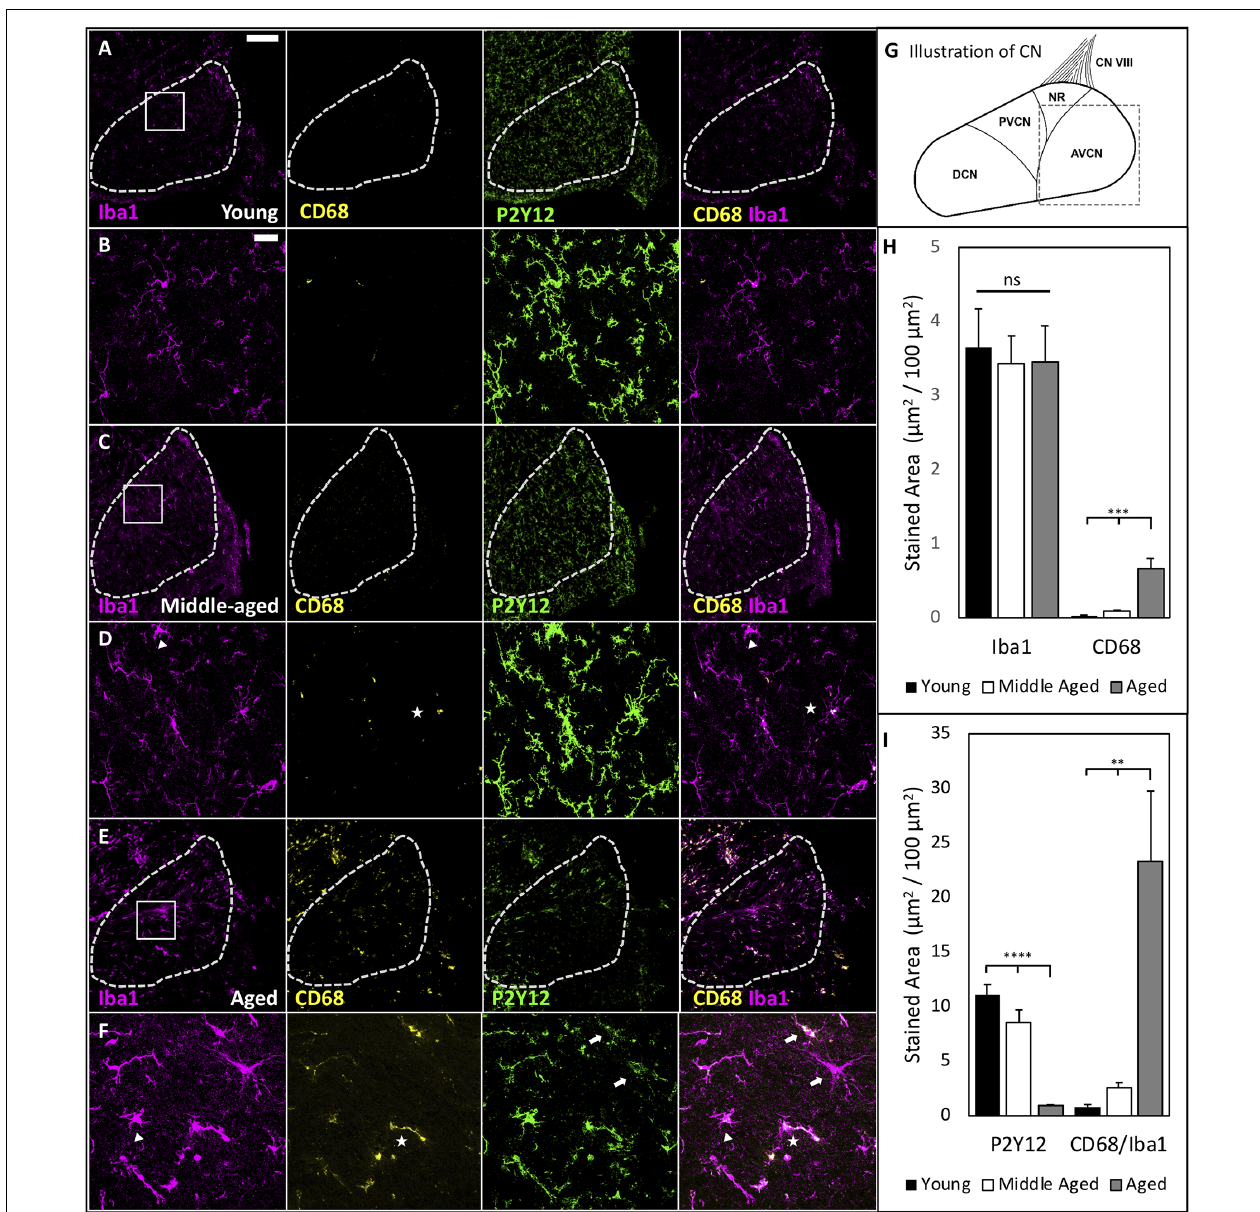
FIGURE 3 | Age-associated microglia activation in the CN. (A) Representative images showing the staining of Iba1, CD68, P2Y12, and the overlapped image of Iba1 and CD68 in the AVCN of young mice. Dashed line marks the AVCN area for analysis; scale bar: 200 µ m. (B) Magnified view of the ROI from (A) ; scale bar: 25 µ m. (C–F) Same images obtained from middle-aged mice (C,D) and aged mice (E,F) . Triangles mark: microglia with activation-associated morphology; arrows: microglia with major downregulation P2Y12; and stars: microglia with increased CD68 content. Importantly, these three approaches to identify activation capture various populations, suggesting heterogeneity of microglial activation in aged mice. Notice, for example, one of two microglia with downregulated P2Y12 (top arrow) also had increased CD68 staining, while the other does not. (G) Schematic of the CN. Dashed square mark AVCN as shown in (A,C,E) . (H) Summary changes of Iba1- and CD68-labeled area during aging. Iba1-labeled area did not significantly differ between groups, while CD68 increased with age. One-way ANOVA: ∗∗∗ p < 0.001. ns: not significant. (I) P2Y12 is downregulated during late-stage ARHL when the most dramatic increase in phagocytic activation occurs as quantified by colocalized area µ m 2 /100 µ m 2 CD68/Iba1. One-way ANOVA: ∗∗ p < 0.01; ∗∗∗∗ p < 0.0001.